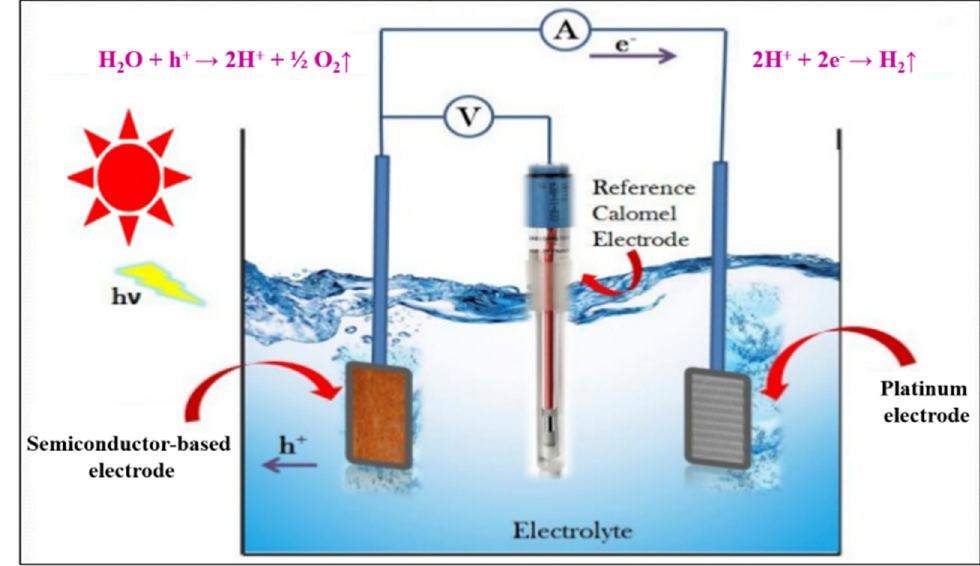
Figure 2. Schematic representation of PEC water splitting mechanism.